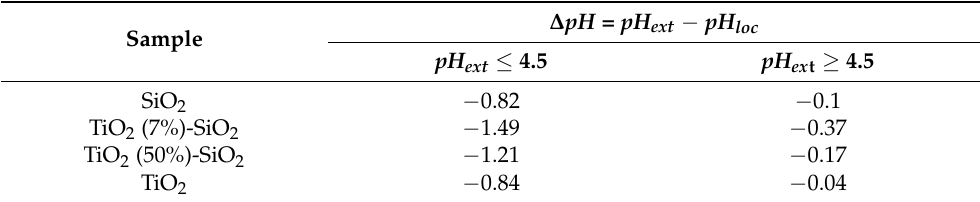
Table 3. The differences in pH ext and pH loc for the oxide